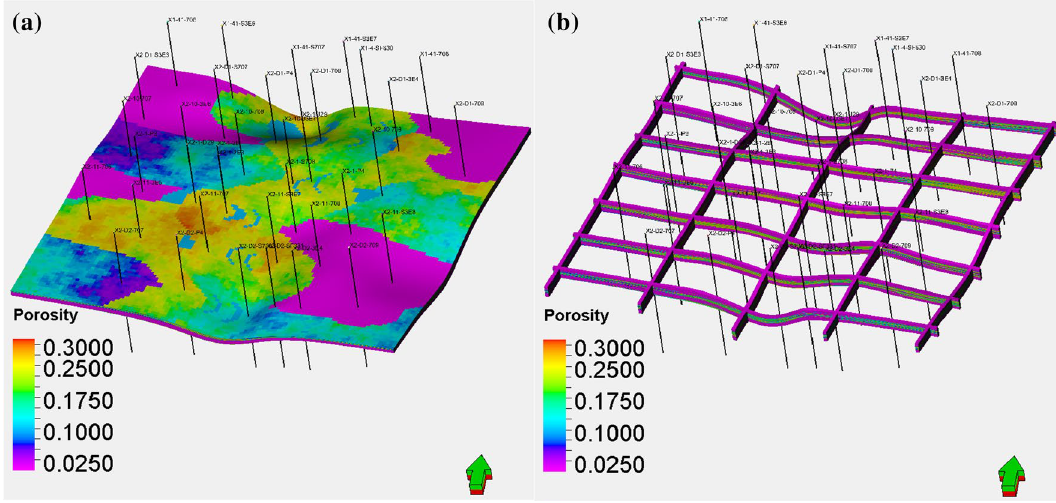
Fig. 7 Porosity model in study area. a Porosity model in study area; b porosity fence model in study